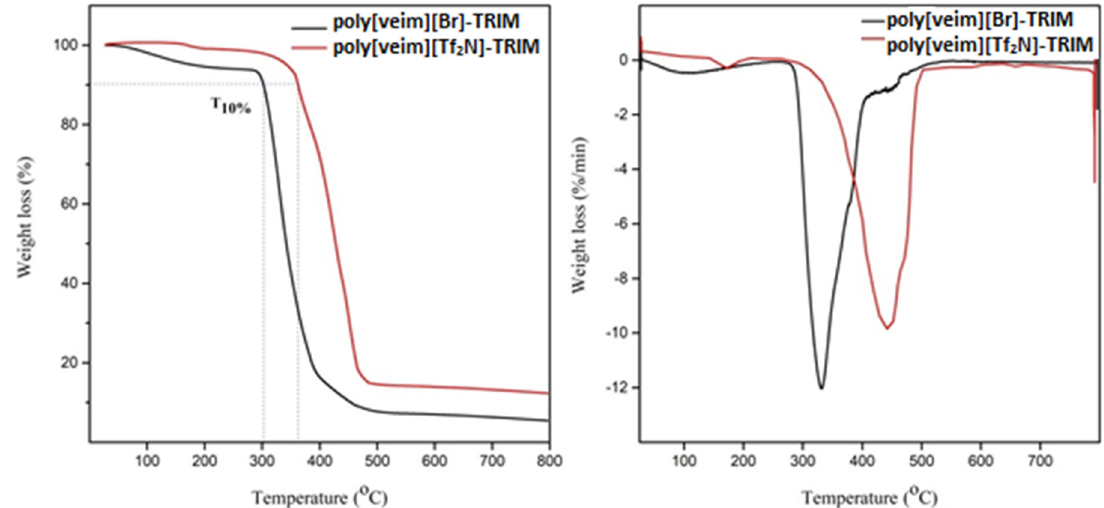
Figure 5. TGA and DTG plots for poly[veim][Br]-TRIM and poly[veim][Tf 2 N]-TRIM.